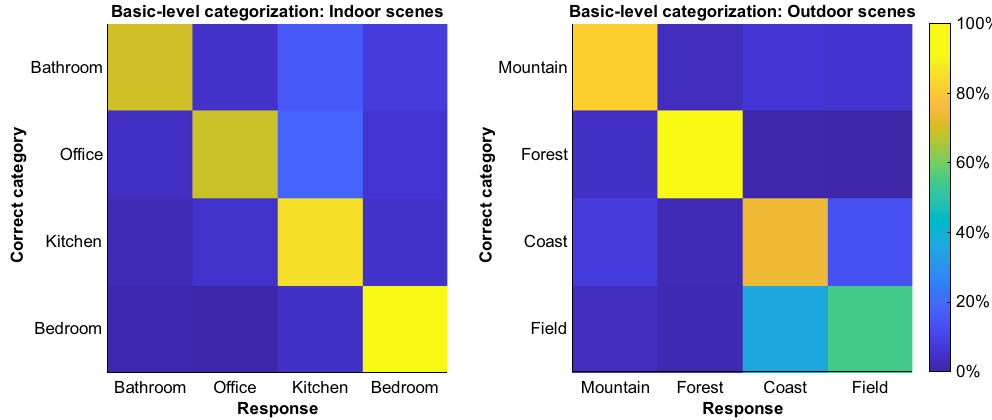
Figure 4. Confusion matrix for the actual category of a stimulus and the participants’ responses in Experiment 1 and